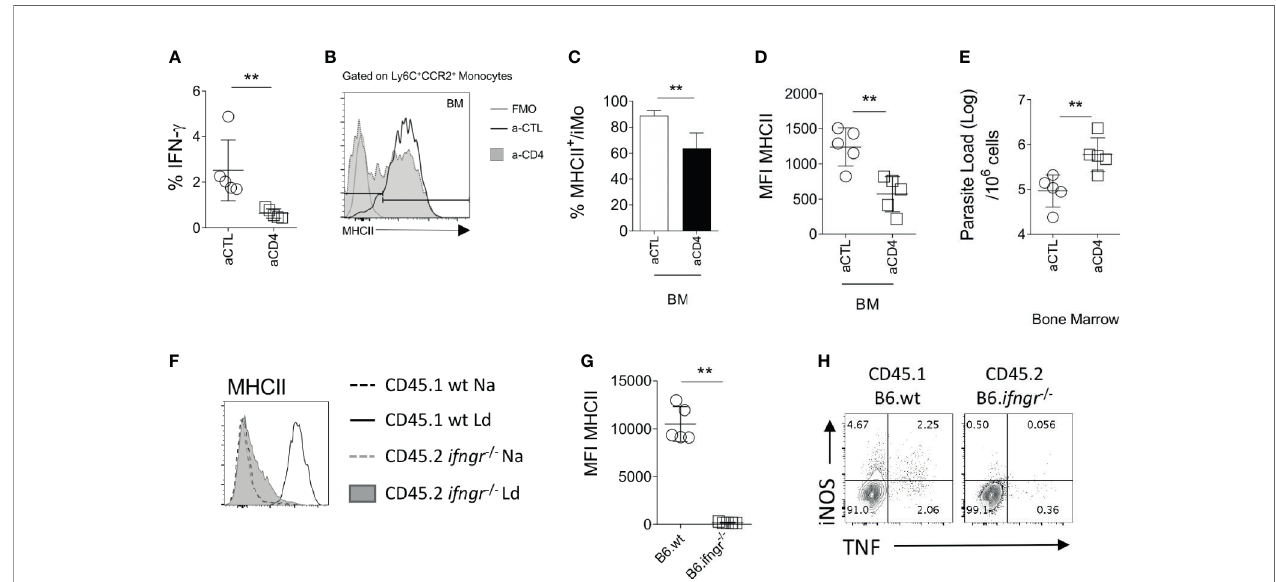
FIGURE 3 | Monocytes respond to IFN- g produced by CD4 + T. (A – E) At day 14 p.i, B6.wt mice were injected with an anti-CD4 depleting antibody or a control antibody for 14 days. All the data shown correspond to BM results. (A) Ex vivo IFN g produced in the BM. Mann-Whitney test applied: P=0.0079 (**); 95% CI: -8.496 – -2.435; statistical power: 96.3%; n =5. Histogram and bar graph representing the expression (B) and percentage (C) respectively, of MHCII on Ly6C + CCR2 + monocytes. Welch ’ s t test applied in (C) : P=0.0027 (**); 95% CI: -26.26 – -8.97; statistical power: 99.2%; n =5. (D) MFI of MHCII and CD80 on the Ly6C + CCR2 + monocytes. Welch ’ s t test applied in (D) : P=0.0036 (**); 95% CI: -1053 – -290.5; statistical power: 99.2%; n =5. (E) Parasite burden measured in infected B6 at d28 by limiting dilution assay. Welch ’ s t test applied in (E) : P=0.0082 (**); 95% CI: 0.275 – 1.346; statistical power: 86.3%; n =5. (F – H) Naïve lethally irradiated B6.CD45.1 recipient mice received a 50:50 of BM cells from B6.CD45.1 and B6. Ifngr1 -/- CD45.2 mice. Subsequently infected with 3x10 7 L. donovani amastigotes for 28 days. (F, G) At day 28, the level of activation of Ly6C + CCR2 + monocytes cells was determined based on the level of expression of MHCII. Mann- Whitney test applied in G: P=0.0079 (**); 95% CI: -12838 – -8928; statistical power: 100%; n=5. Data are the pool of 5 mice/group/experiment. Mean +/- SD is shown. (H) Dot plot representative of the production of NOS2 and TNF by CD45.1 or CD45.2 Ly6C + CCR2 + monocytes in the